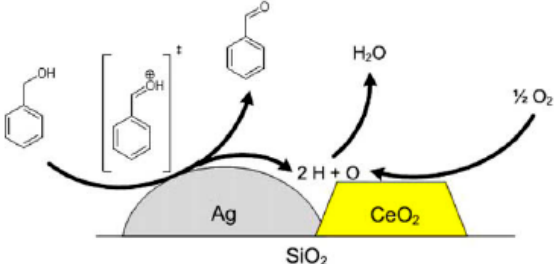
Figure 15. Schematic and simplified reaction mechanism of benzyl alcohol oxidation with O 2 over Ag/SiO 2 in presence of ceria. Benzyl alcohol oxidation occurs via adsorption of substrate on silver surface, dehydrogenation followed by desorption of benzaldehyde. Hydrogen is removed from the silver surface by means of atomic oxygen provided by the CeO 2 -Ag interface.Reprinted with permission from reference [119]. Copyright 2009 Elsevier.